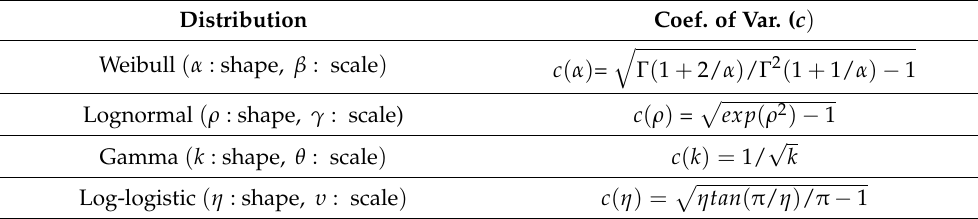
Table 1. The coefficient of variation for common life distributions that have shape parameters. Distribution Coef. of Var. ( c